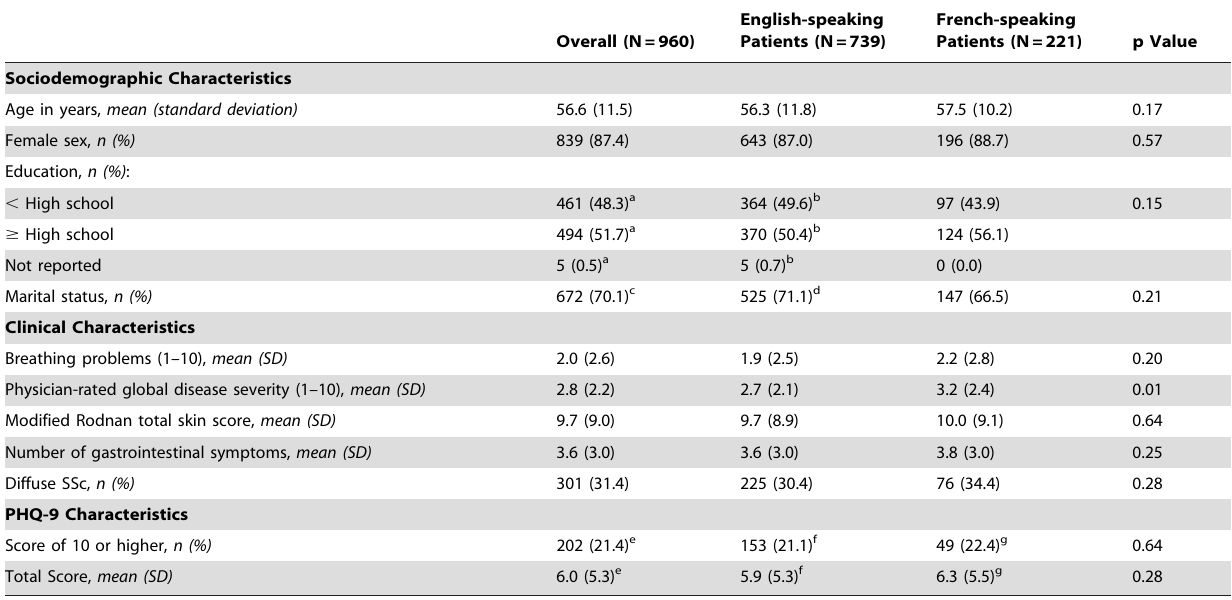
Table 1. Clinical